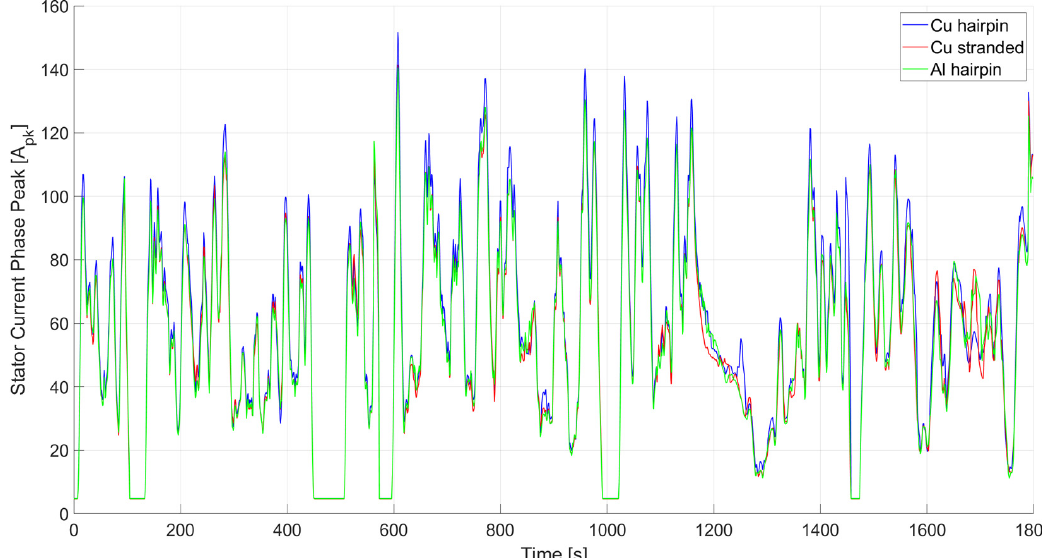
Figure 10. Efficiency in WLTP class 3 drive cycle.